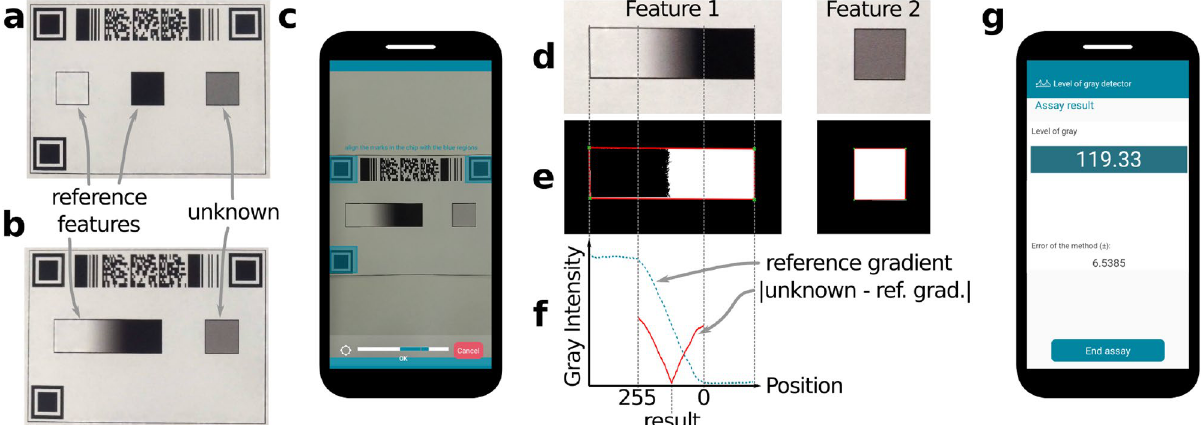
Figure 3. Application case #1: grayscale detector. The chips used include two kinds of features: the unknown and the color references, provided as ( a ) the extreme gray values or ( b ) a gradient with the full palette. ( c ) A screenshot of the mobile app showing the auto-shooting step. ( d ) The cropped features are passed to the algorithm for processing. ( e ) The algorithm segments the analyzed features in order to recognize the pixels containing useful information. ( f ) Plot of the measured reference gradient and the absolute error (between such gradient and the mean unknown value) as a function of position. The position where the error reaches a minimum is proportional to the unknown gray value. ( g ) Screenshot of the final report showing the obtained result.